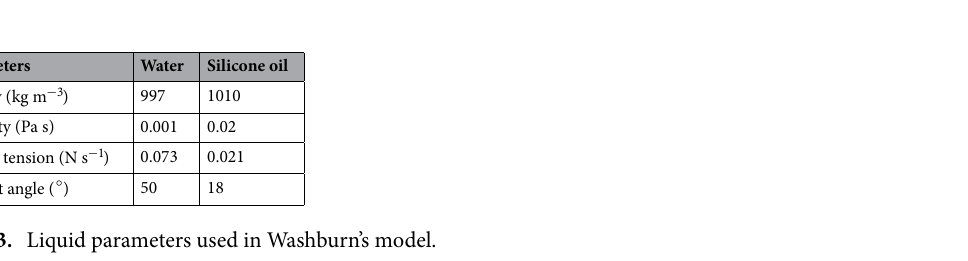
Table 2. Tissue parameters used in Washburn’s model.